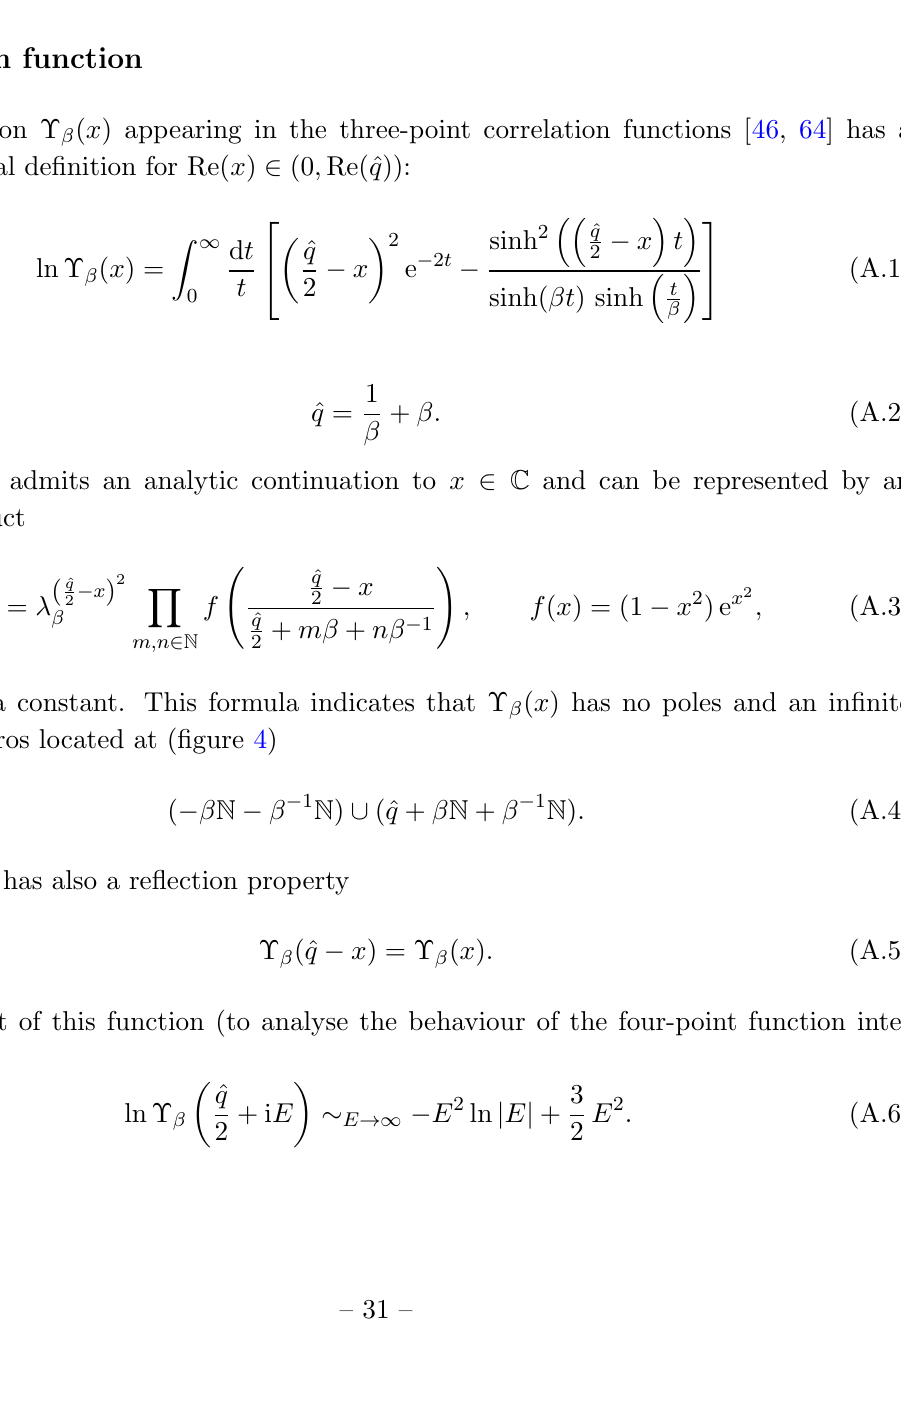
Figure 4. Zeros of the function (cid:7) (cid:12) ( x ) for (cid:12) 2 C . If (cid:12) 2 R (resp. (cid:12) 2 i R ), the zeros become all real (resp. pure